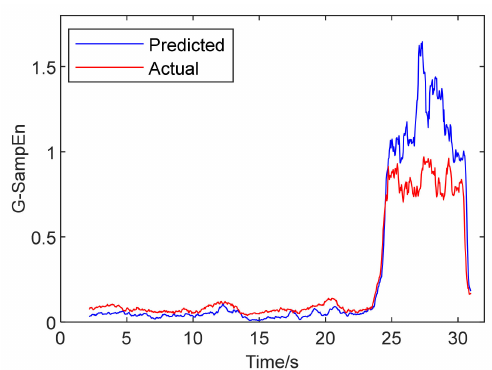
Figure 15. Dynamic G-SampEn of spatial mode amplitude in multi-step prediction.